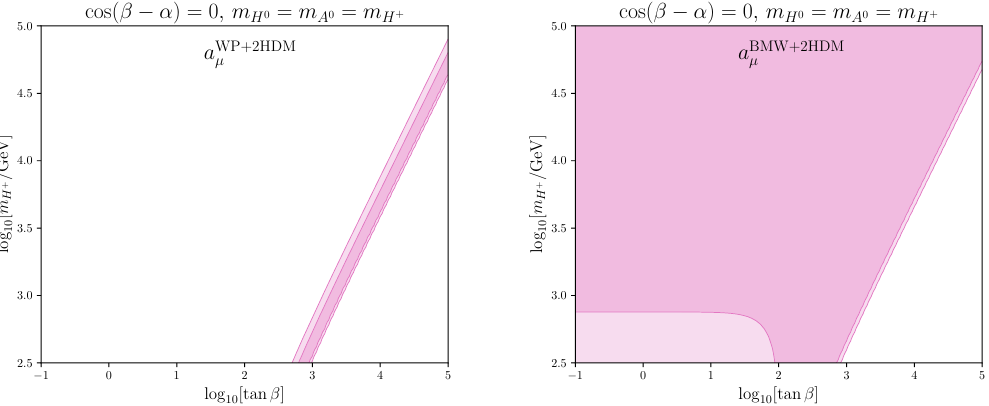
Figure 20. Contour plots of the allowed 2HDM-II parameter space in the (tan β − m for a µ , using the Standard Model prediction by WP20 [15] (BMW [16]) (left (right) plot), fixing the additional parameters as cos( β − α ) = 0 , m the allowed parameter space at 2 σ confidence level while the darker contour corresponds to 1 σ